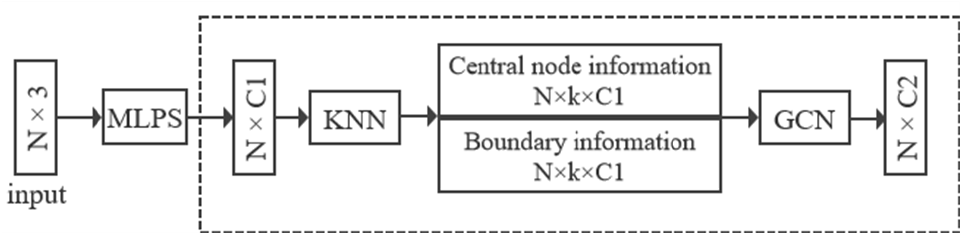
Figure 2. Feature extraction module using GCN.